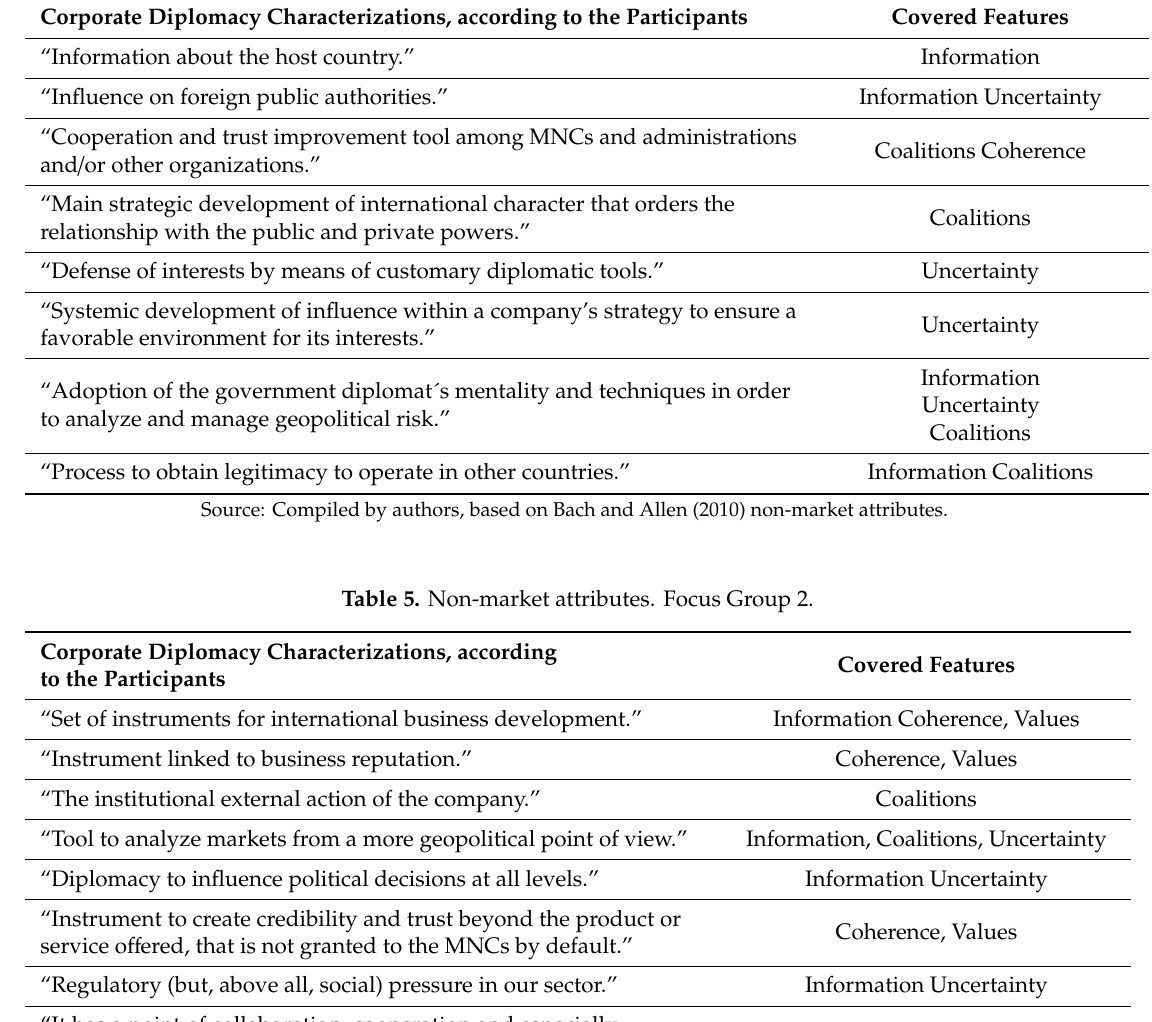
Table 4. Non-market attributes. Focus Group 1.